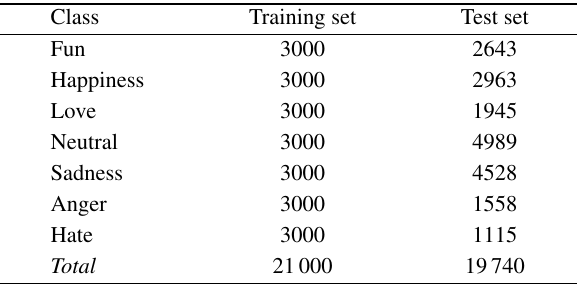
Fig. 1 Main interface of SENTA. Table 1 Structure of the dataset